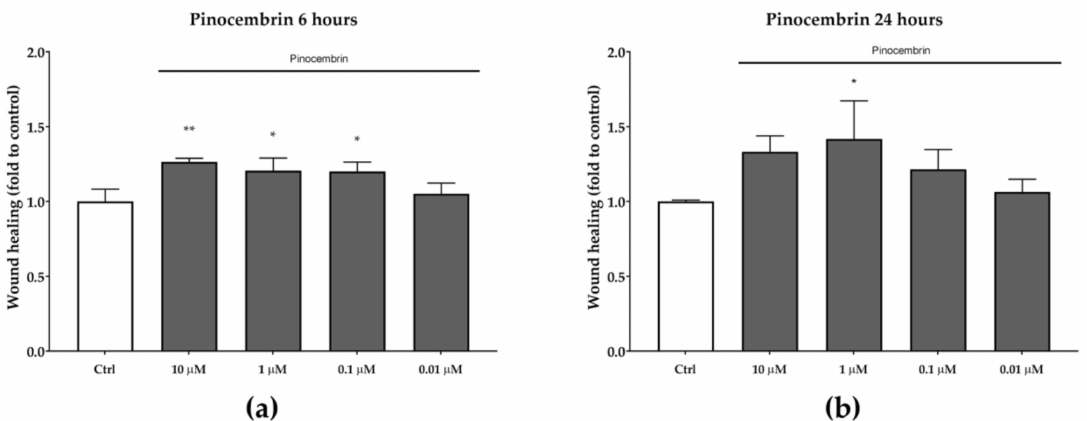
Figure 5. Wound-healing activity of pinocembrin after six hours ( a ) and 24 hours ( b ). * p < 0.05 vs. control; ** p < 0.01 vs. control.